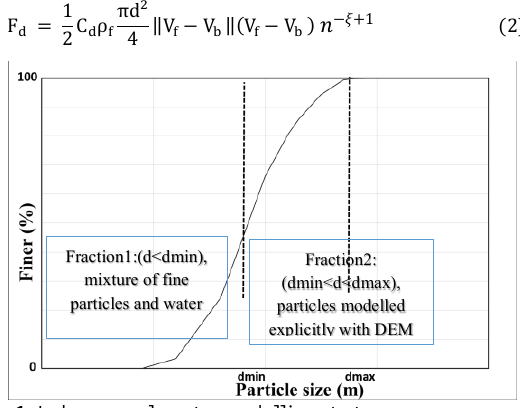
Fig. 1. Lahar granulometry modelling strategy.